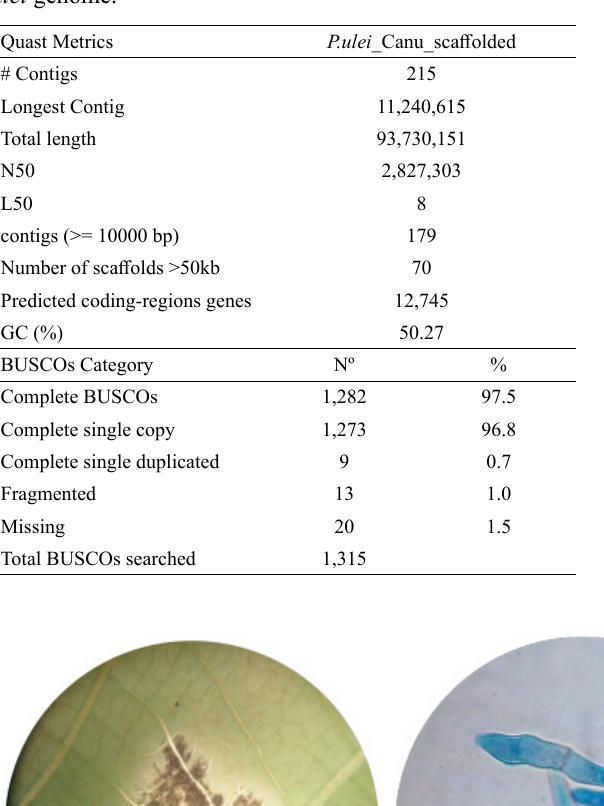
Table 1 – Assembly quality metrics of the scaffolded P. ulei genome.